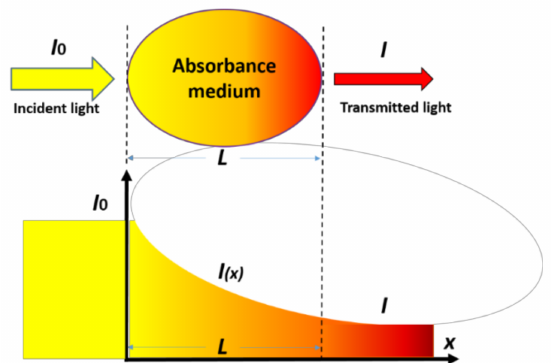
Figure 1. A schematic representation of Beer-Lambert’s law to show relationship between the attenuation of incident light through an object the properties of that object, adopted from Sun and Chuang